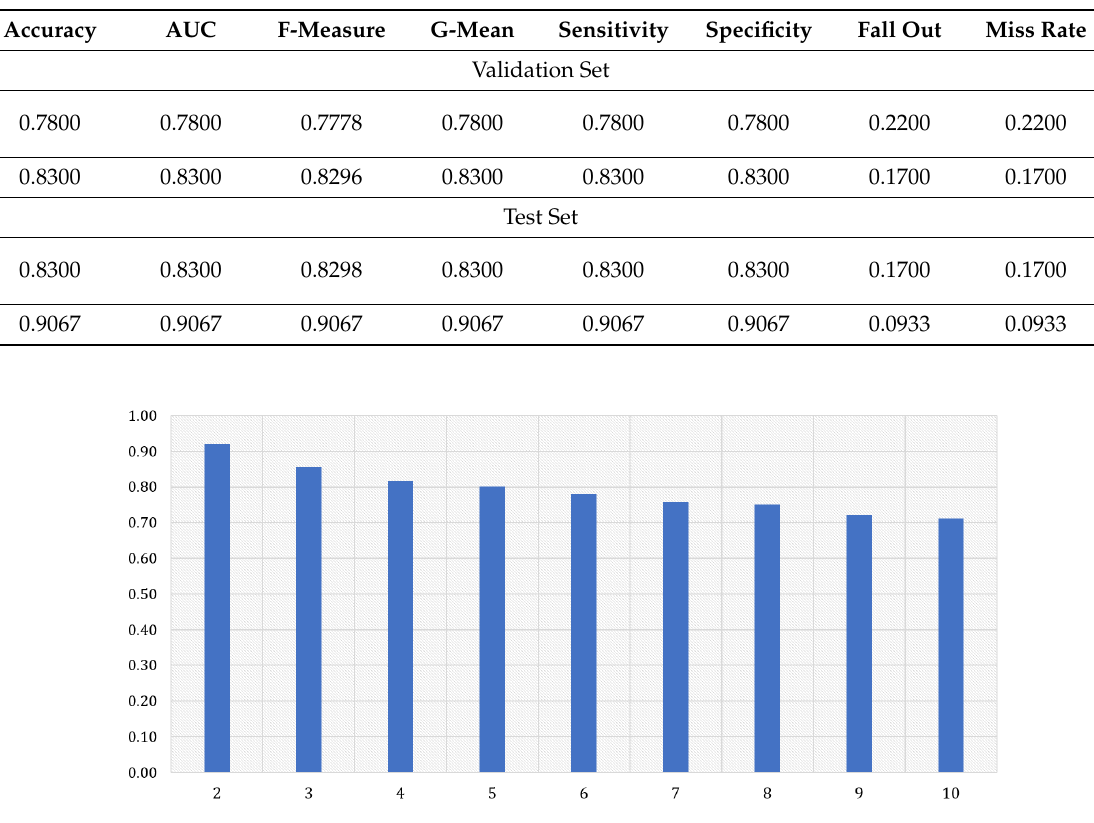
Figure 4. Accuracy of improved MobileNet-V1 for different clustered group, where the x-axis labels indicate different values of K = 2, 3, ..., 10, and the y-axis label shows the